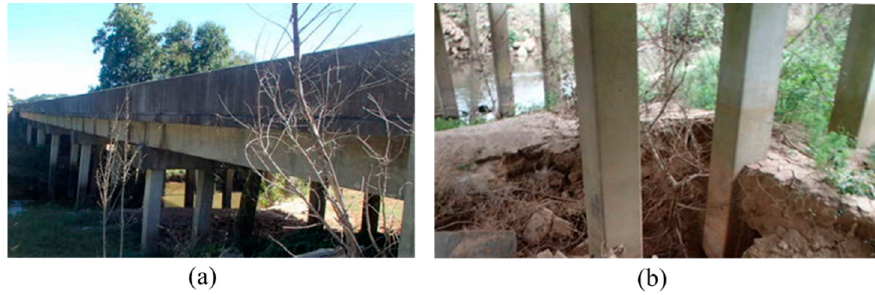
Figure 11. Selected bridge with a low RI: ( a ) side view and ( b ) substructure view in 2021.